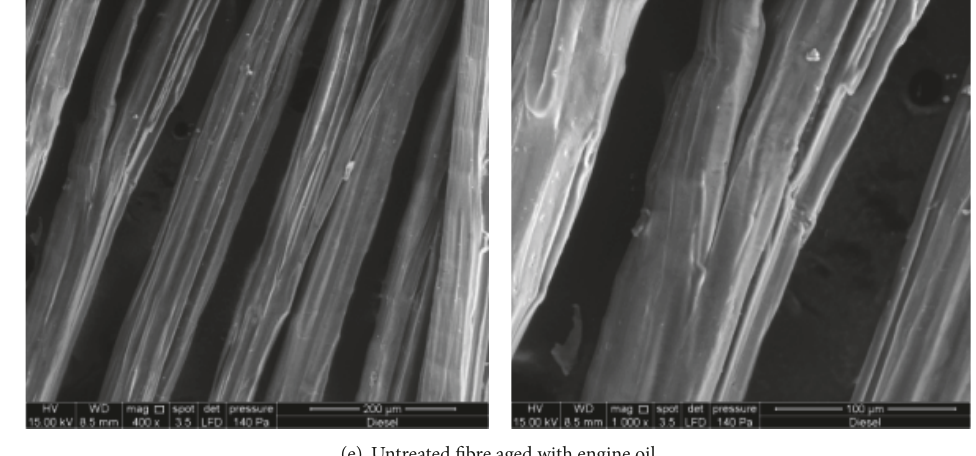
Figure 5: SEM micrograph of aged untreated kenaf fibre